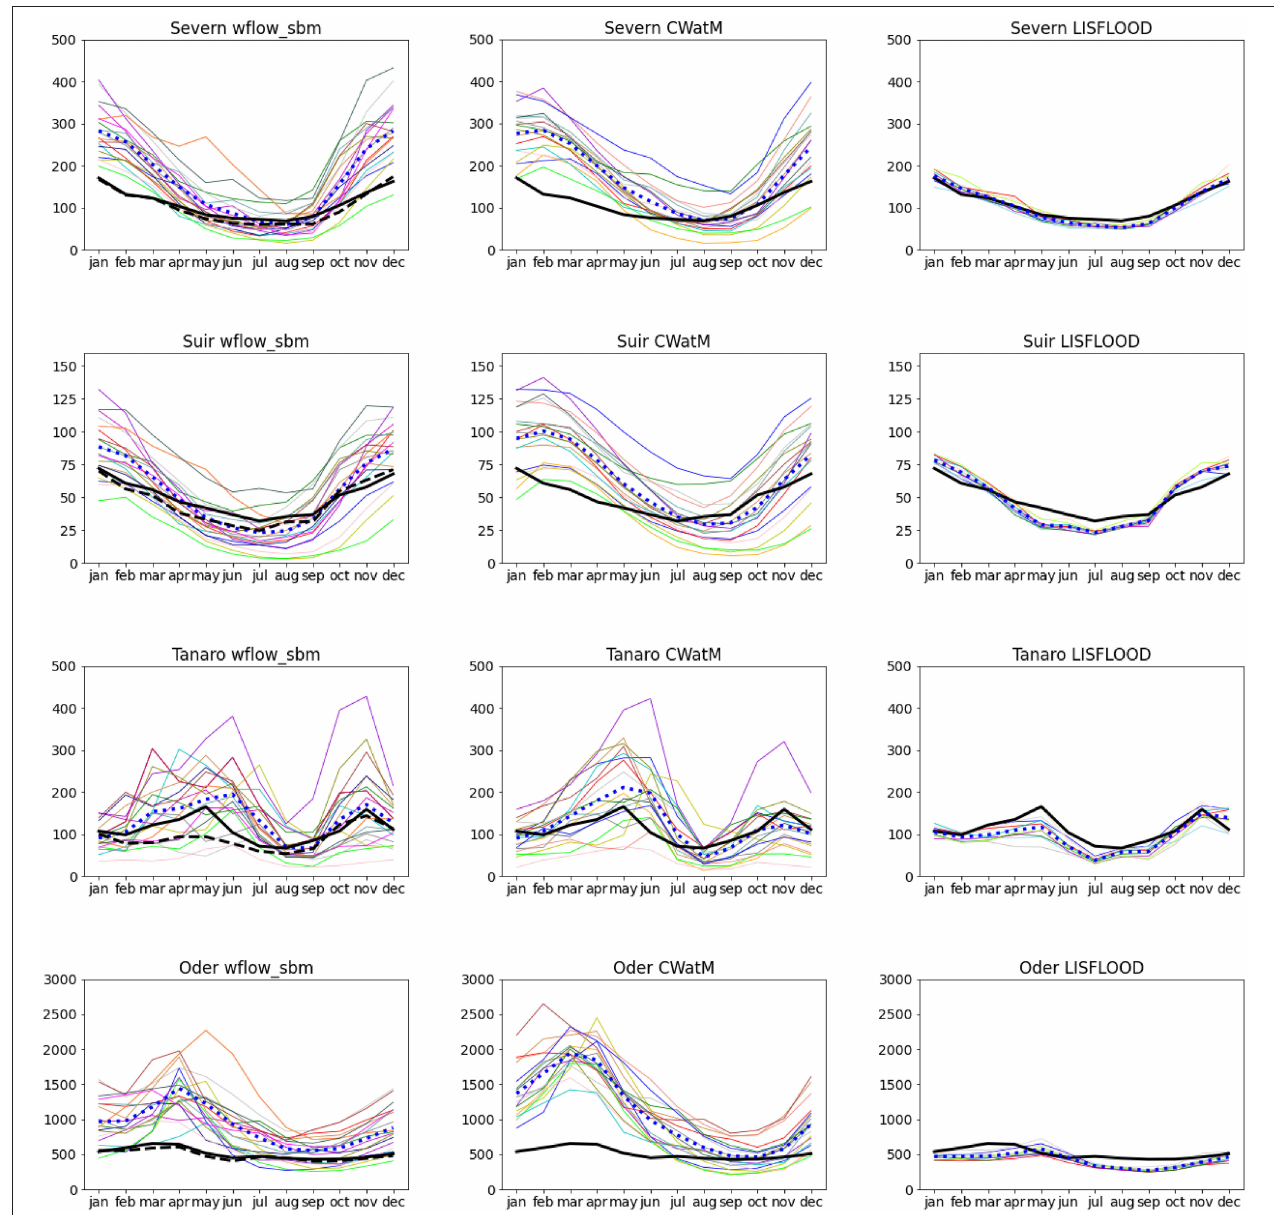
FIGURE 3 | Historical discharge regimes (m3 s-1) calculated over the period 1981–2010 from the CORDEX simulations (colored lines), the ensemble mean (blue dotted line) with from left to right (wflow_sbm, CWatM and LISFLOOD), observed discharge (black) and reference wflow_sbm run based on EOBS (dashed black). To refer to the CORDEX realizations the same color coding is used in all